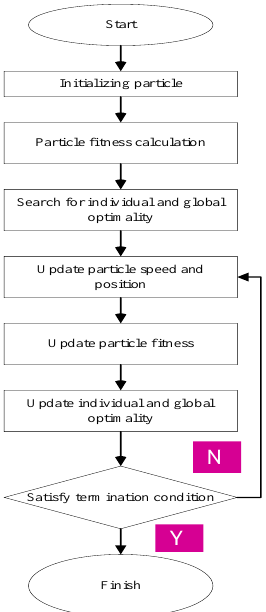
Figure 3. Flow chart of PSO algorithm.